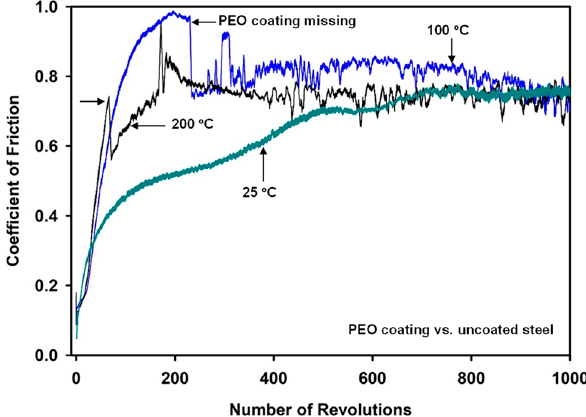
Figure 2. Coefficient of friction variations with the number of sliding revolutions for PEO-coated AZ31 when tested against uncoated steel at 25 °C, 100 °C and 200 °C. The missing PEO coating is indicated by arrows.